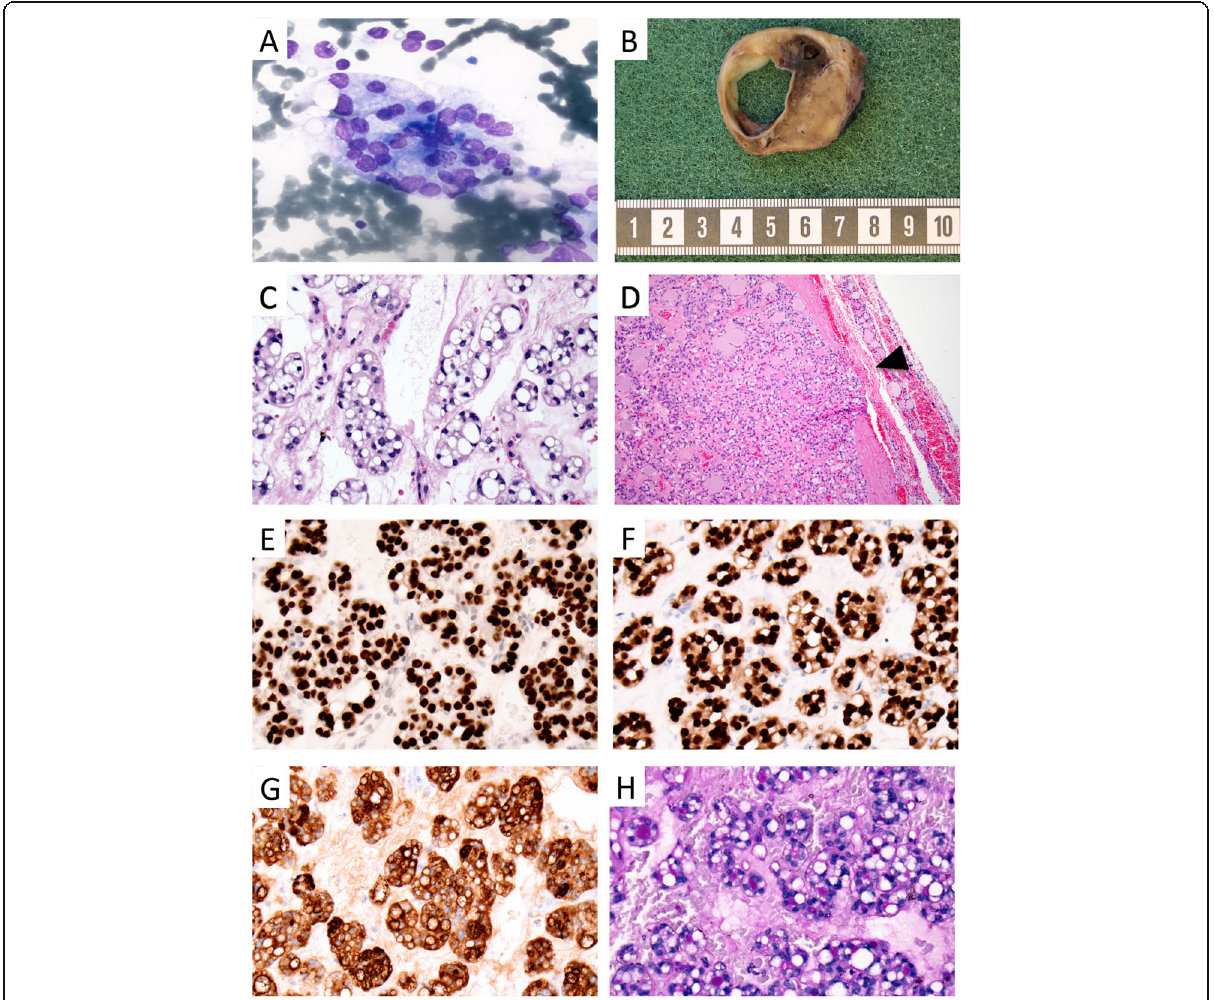
Fig. 1 Cytological, macroscopic and histological illustrations of case 1. a Cytological preparation from the thyroid lesion at ×1000 magnification depicting thyrocytes with large, irregular nuclei with suggestive nuclear marginalization in subsets of cells. No clear-cut signet ring cell phenotype was evident. b Macroscopic view of a coronary section through the thyroid lesion, visualizing a 38 mm encapsulated tumor with a tan cut surface, focal hemorrhages and a central cystic clearing. c H&E staining of the thyroid tumor at × 400 magnification, portraying thyrocytes with cytoplasmic vacuolization and nuclear marginalization (signet ring cell appearance) in the majority of tumor cells. d Representative focus depicting capsular invasion, marked with an arrowhead, × 100 magnification. e-g Immunohistochemical analyses at × 400 magnification; TTF1 nuclear stain ( e ), PAX8 nuclear stain ( f ), thyroglobulin cytoplasmic stain, including subsets of vacuoles ( g ). h: Histochemical PAS stain at × 400 magnification, note how the cytoplasmic vacuoles stain